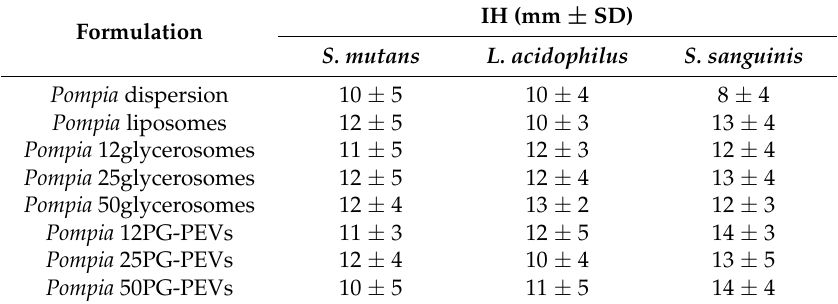
Table 4. Inhibition halo (IH) for pompia extract in dispersion or loaded in the vesicular formulations